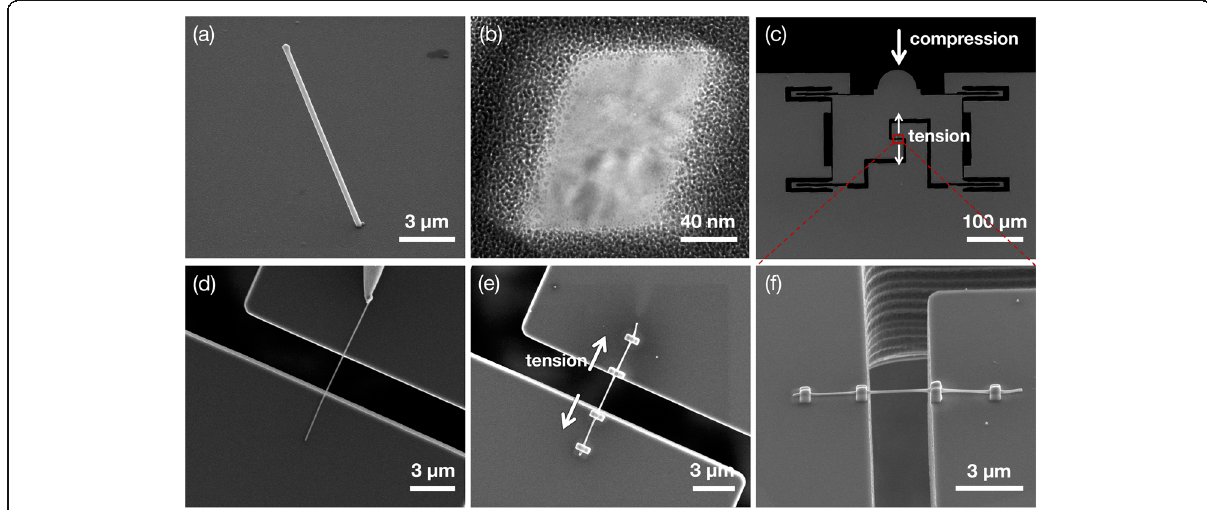
Fig. 1 Micrographs of ( a ) Al NW grown on the SiO 2 substrate and ( b ) its cross-sectional view. c Secondary electron image showing the push-to- pull (PTP) loading device, which converts a compressive load to a tensile load. d - f Magnified views of the rectangle denoted in ( c ); d The Al NW transported to the PTP loading device by picking up with the W tip of the nanomanipulator. The NW welded to the PTP device using e-beam assisted Pt deposition viewed from the ( e ) top and ( f )